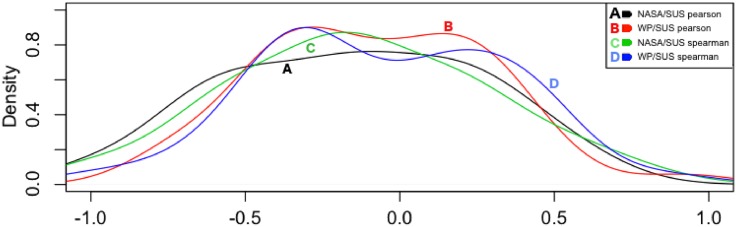
Density plots of the correlations by user.